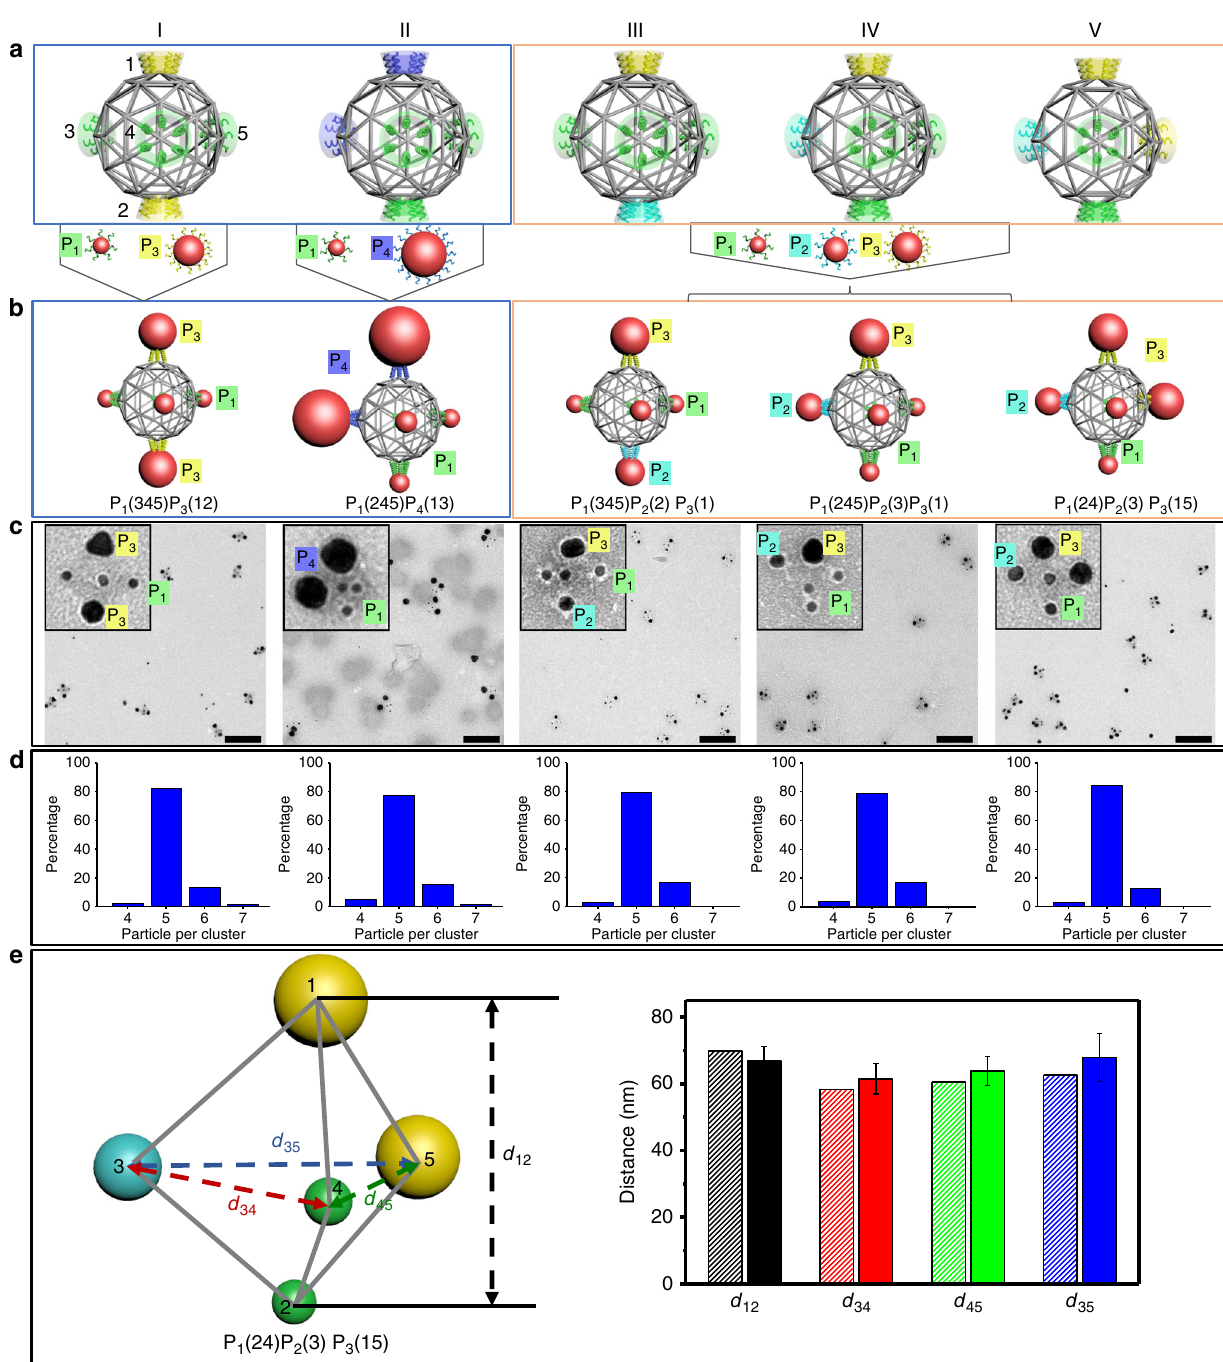
Fig. 5 Design and characterization of multitype NPs clusters assembled with a meshframe of directional and polychromatic valence modes. a Meshframe programmed with a valence of TBP geometry and encoded ‘ colored ’ sites at selected vertices, labelled from 1 to 5, results in polychromatic valence. (I – II) two-color valence. (III – V) three-color valence. b Multitype NP clusters. (I) P 1 (345)P 3 (12) with three P 1 (10 nm AuNP) at sites 3 – 4 – 5 and